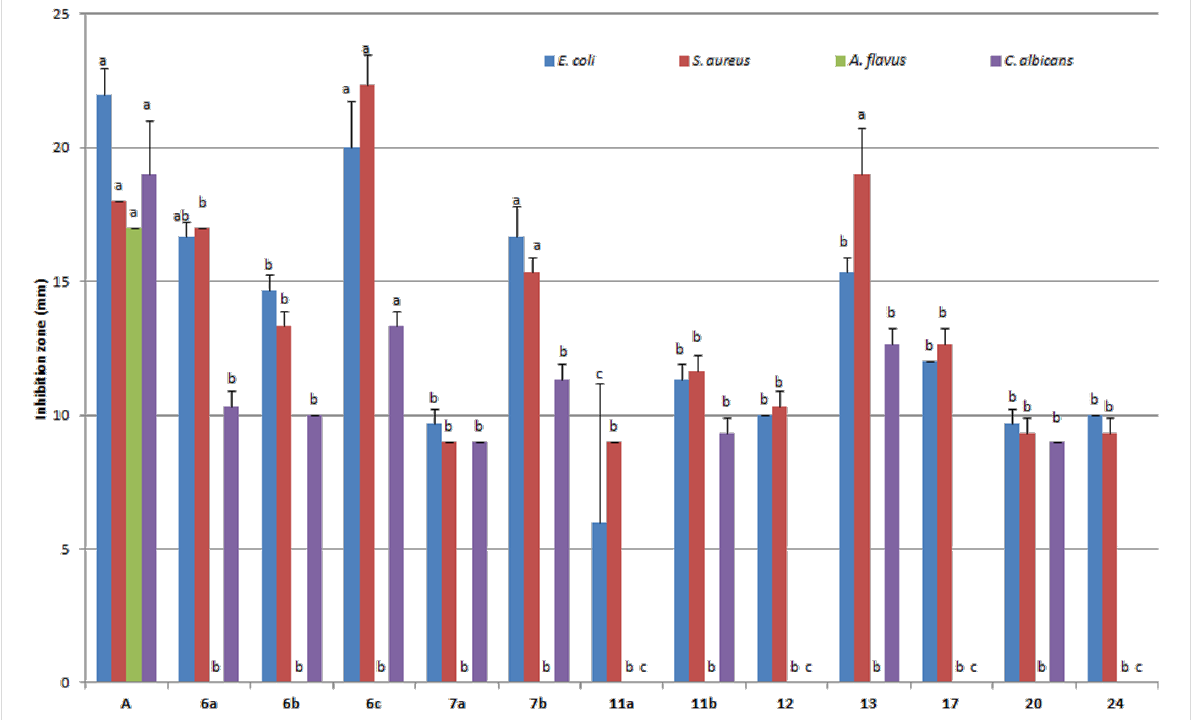
Figure 2: In vitro antimicrobial activity of some new cholesterol derivatives against E.coli , S. aureus . A. flavus and C. albicans . Ampicillin was used as positive control ( A ) in the case of E. coil and S. aureus , while, amphotericin B was used in the case of A. flavus and C. albicans . Different letters on the column for each parameter varied significantly at p ≤ 0.05. These characters (a, b, etc) above the columns denote to statistical variances. Two or more columns with different vertical values but specified with the same character mean that their variation is not significant, i.e., they are equally